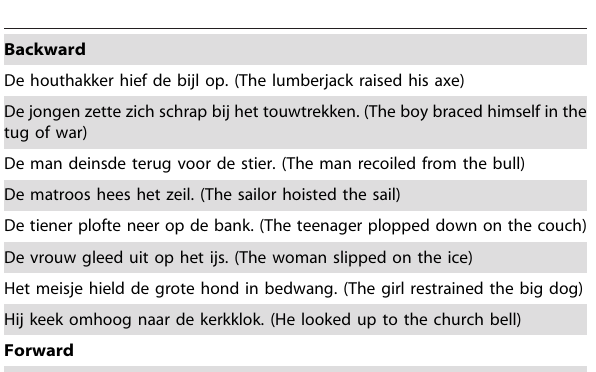
Table 1. Stimulus Sentences: Dutch original (English